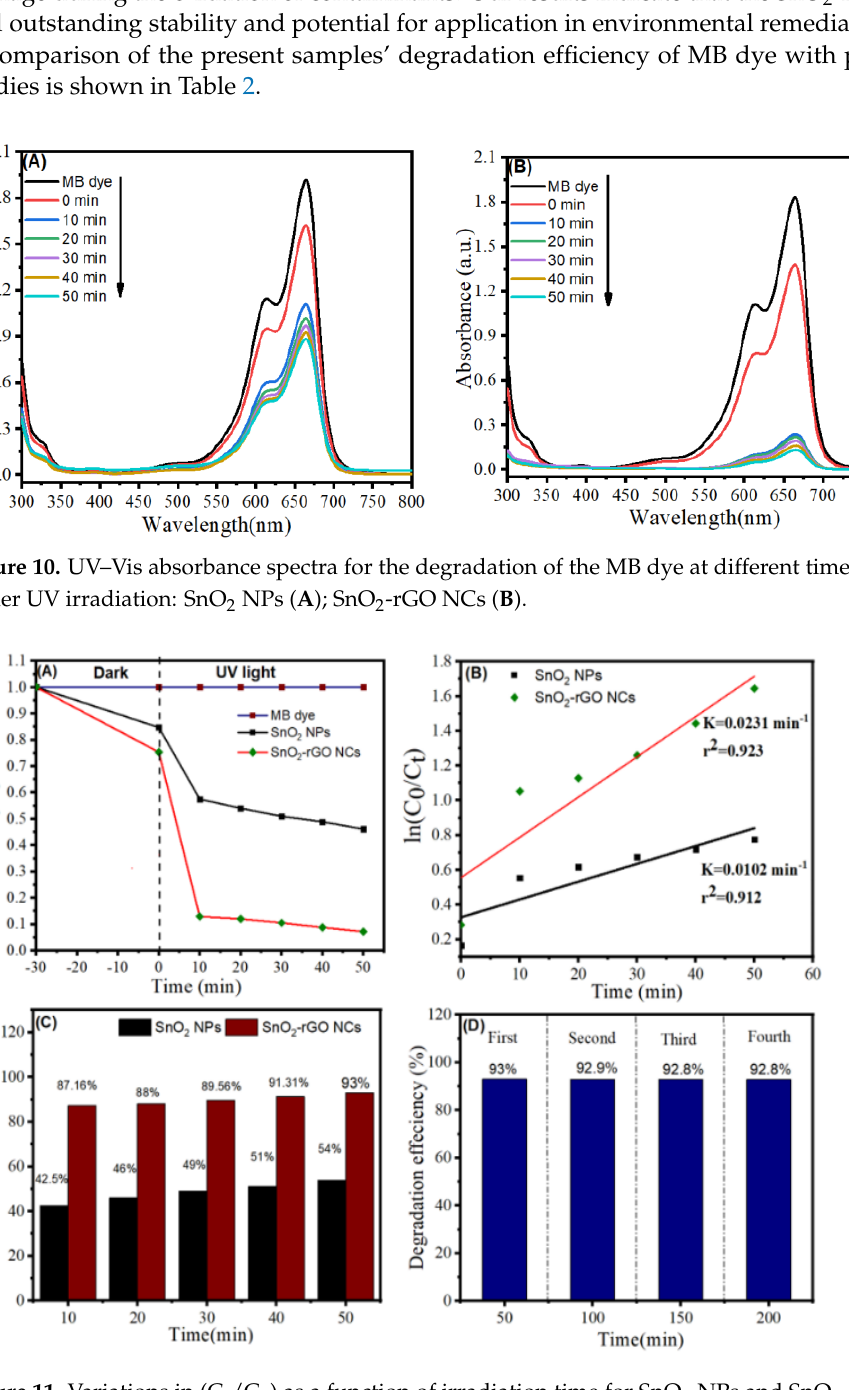
Figure 11. Variations in (C t /C 0 ) as a function of irradiation time for SnO 2 NPs and SnO 2 -rGO NCs ( A ), The plot of ln(C 0 /C t ) as a function of light exposure time ( B ), the degradation efficiency of the SnO 2 NPs and SnO 2 -rGO NCs ( C ), and four cycling runs of the SnO 2 -rGO NCs for the degradation of the MB dye under UV irradiation ( D ). Table 2. Comparison of the MB dye degradation efficiency of the present samples with previous studies.